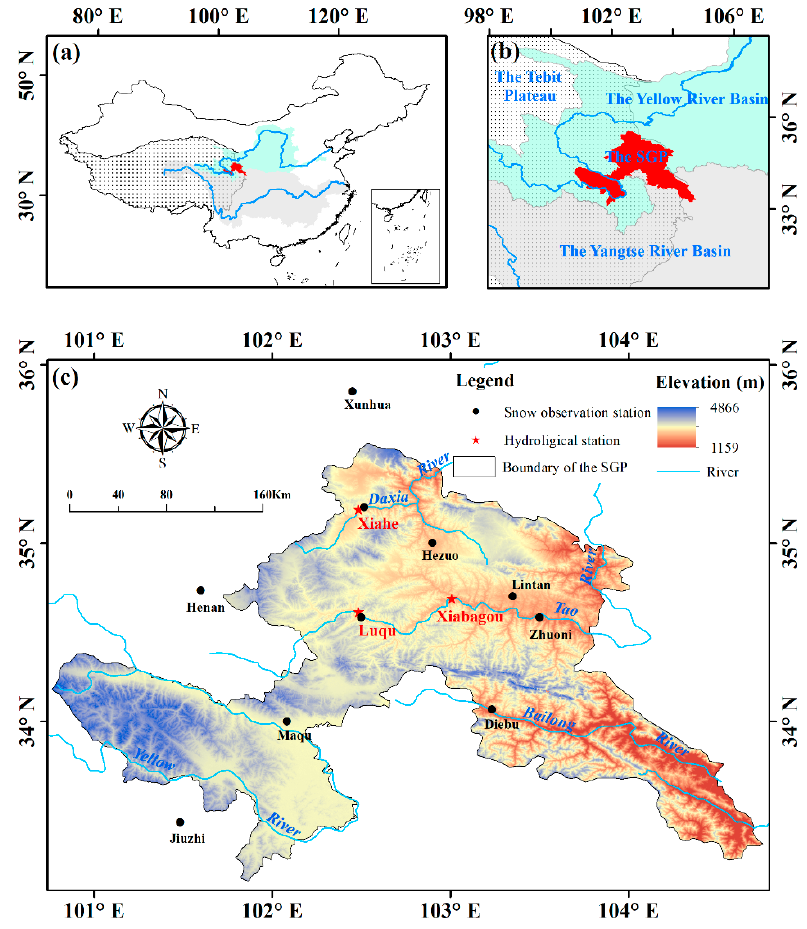
Figure 1. Overview of the study area, including the geographic location on the northeast edge of the Tibetan Plateau ( a ), the water source area in the upper reaches of the Yellow River and Yangtze River ( b ), and the distribution of elevation, stream networks, and snow and hydrological observation stations ( c ).